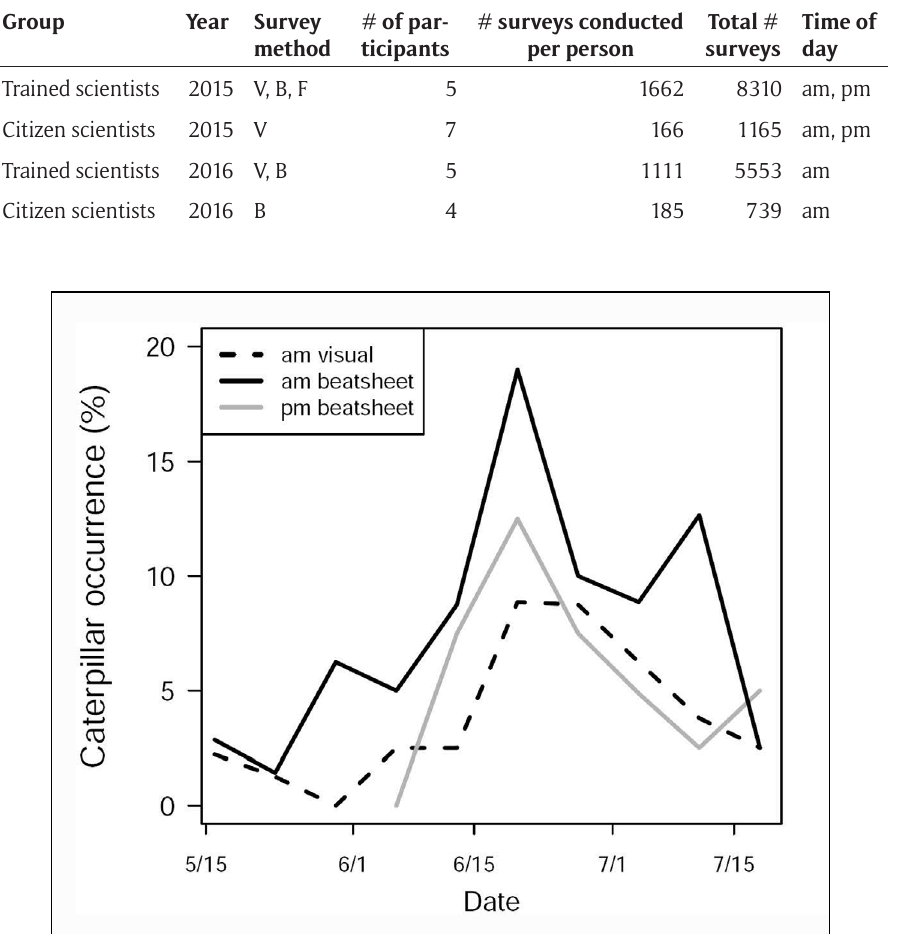
Figure 2: Comparison of caterpillar phenology (fraction of surveys on which at least one caterpillar was detected) at Prairie Ridge Ecostation in 2015 based on morning beatsheet surveys (black solid line), morning visual surveys (black dashed line), and afternoon beatsheet surveys (gray solid